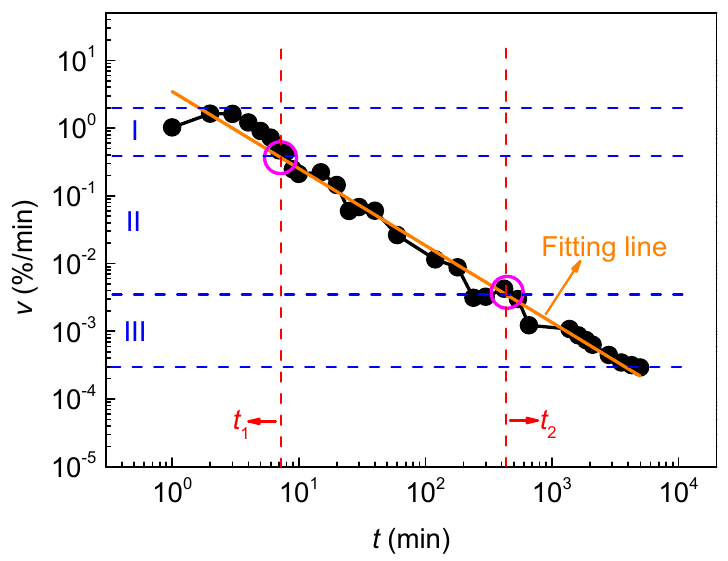
Figure 5. Changes in water absorption velocity v with time t